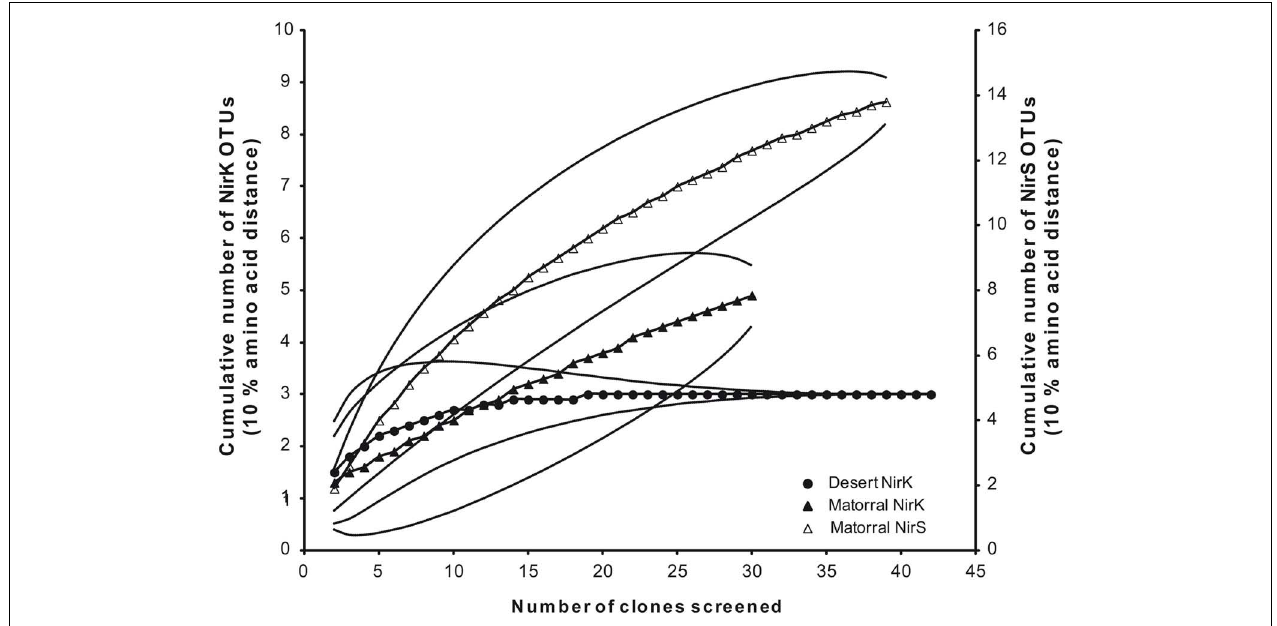
FIGURE 3 | Rarefaction analysis of deduced amino acids of nitrite reductase genes from the sclerophyllous matorral ( (cid:2) , Δ ) and theAtacama Desert ( • ) based on a threshold level of 10% amino acid distance; NirK (closed symbols) and NirS (open